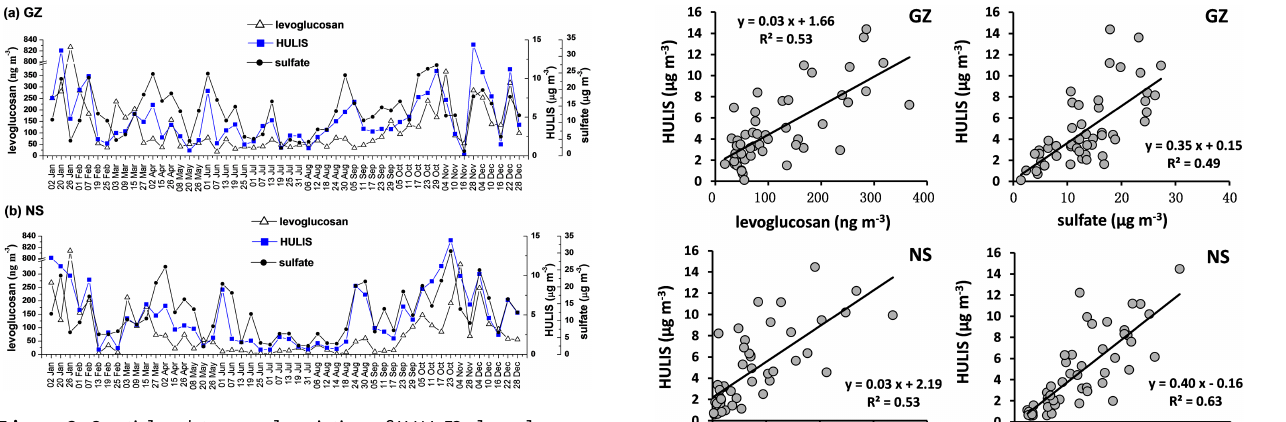
Figure 3. Spatial and temporal variation of HULIS, levoglucosan, and sulfate throughout the sampling year 2009.